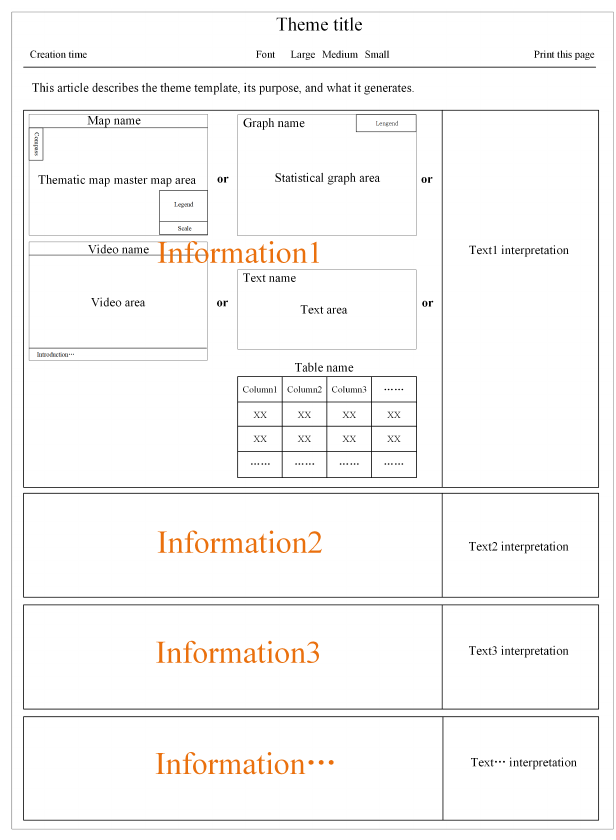
Figure 2. Web design diagram.